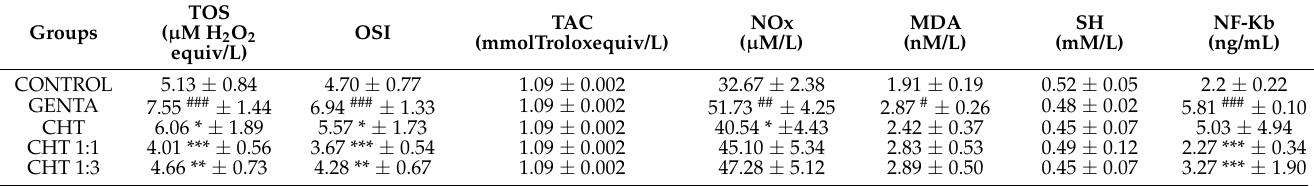
Table 7. Serum oxidative stress markers in rat gentamicin-induced acute kidney injury. Groups